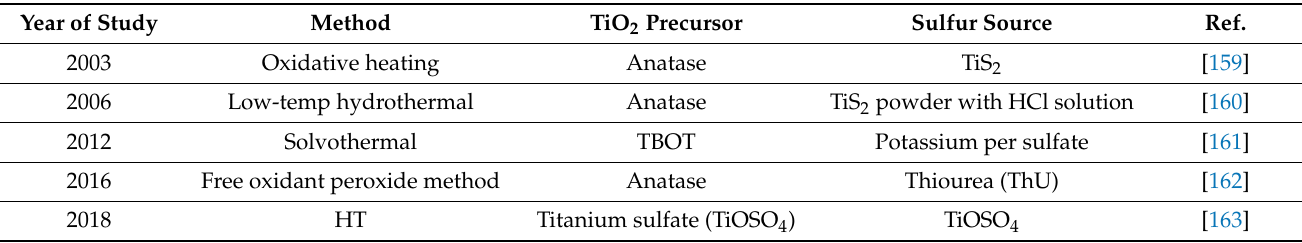
Figure 9. The photocatalytic degradation of phenol using SdST-0.5 at various wavelength irradiation [161]. Table 6. Summary of S-doped TiO 2 photocatalysts synthesized by variety of methods and source precursor materials.